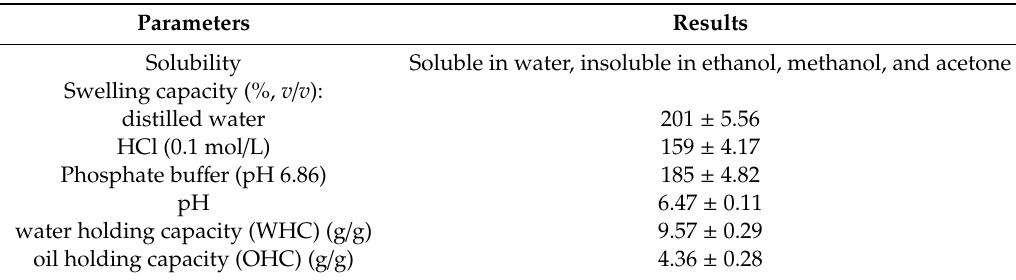
Table 3. Physicochemical properties of PD1-1.